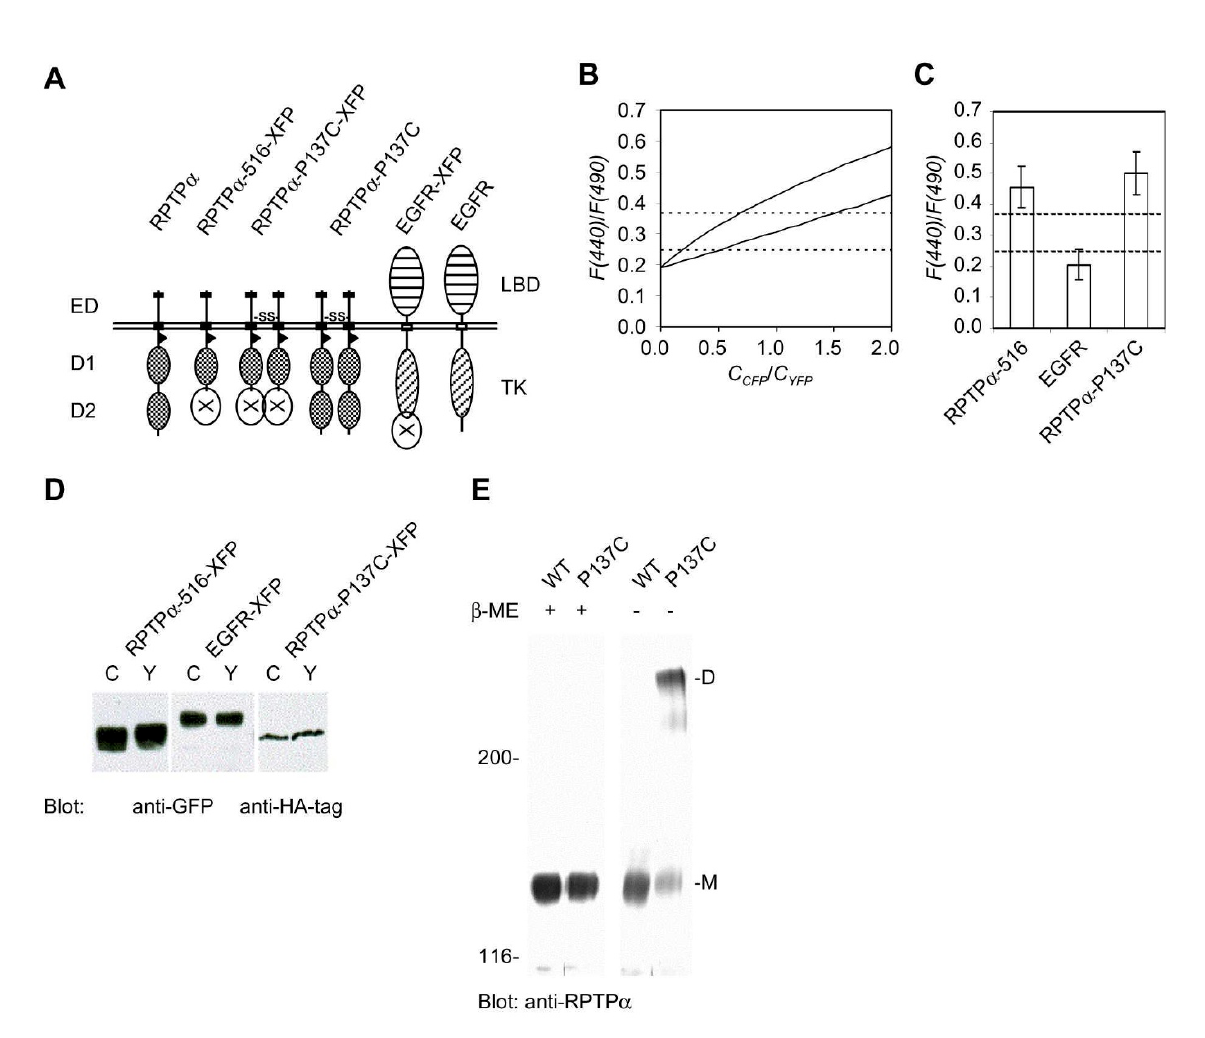
Figure 2 Specific and constitutive dimerization of RPTP α , as assessed by FRET. ( A ) Schematic representation of the constructs that were used. RPTP α -D2 was replaced by CFP or YFP in RPTP α -516-XFP. Pro137 was mutated to Cys in RPTP α -P137C-XFP and RPTP α -P137C, leading to the formation of a disulfide bridge, and thus to constitutive dimerization. In EGFR-XFP, the C-termi- nus of the EGFR was replaced by CFP or YFP. ( B ) Theoretical values of F(440)/F(490) , calculated as described in the Experi- mental Procedures section for no FRET and/or dimerization (bottom trace), or significant dimerization ( E * α = 0.5, upper trace). The dashed lines indicate the F(440)/F(490) levels under conditions of no FRET and/or dimerization with R (CFP/YFP) = 0.5 (lower dashed line), or R (CFP/YFP) = 1.5 (upper dashed line). F(440)/F(490) levels close to the lower dashed line indicate that no FRET and/or dimerization occurs. F(440)/F(490) values above the upper dashed line are most likely due to FRET. F(440)/F(490) values between the two dashed lines are ambiguous, since F(440)/F(490) values may indicate high CFP:YFP expression ratios and no FRET and/or dimerization, or low CFP:YFP expression ratios and little FRET and dimerization. ( C ) SK-N-MC cells were transiently transfected with combinations of CFP- and YFP-fusion proteins, fused to RPTP α -516, to the EGFR, or to constitutively dimeric RPTP α -P137C. The F(440)/F(490) ratios were determined in at least 10 single living cells from at least two independent experiments, and the error bars indicate the standard deviation. The dashed lines indicate the theoretically minimal F(440)/F(490) ratio (bottom dashed line), and the FRET threshold level (upper dashed line). ( D ) Expres- sion of the fusion proteins in (C) was monitored by immunoblotting to verify that similar levels of fusion proteins were expressed, using an anti-GFP antibody (left two panels), or an anti-HA-tag antibody (right panel). ( E ) Wild type RPTP α and RPTP α -P137C were transfected into SK-N-MC cells. Lysates of these cells were run on 5% SDS-PAGE gels under reducing (+ β -mercaptoethanol, β -ME) or non-reducing conditions (- β -ME). Immunoblots, probed with anti-RPTP α antibodies are depicted with the molecular weight of marker proteins that were co-electrophoresed with the samples on the left (in kDa). The position of monomeric (M) and dimeric (D) RPTP α is depicted on the